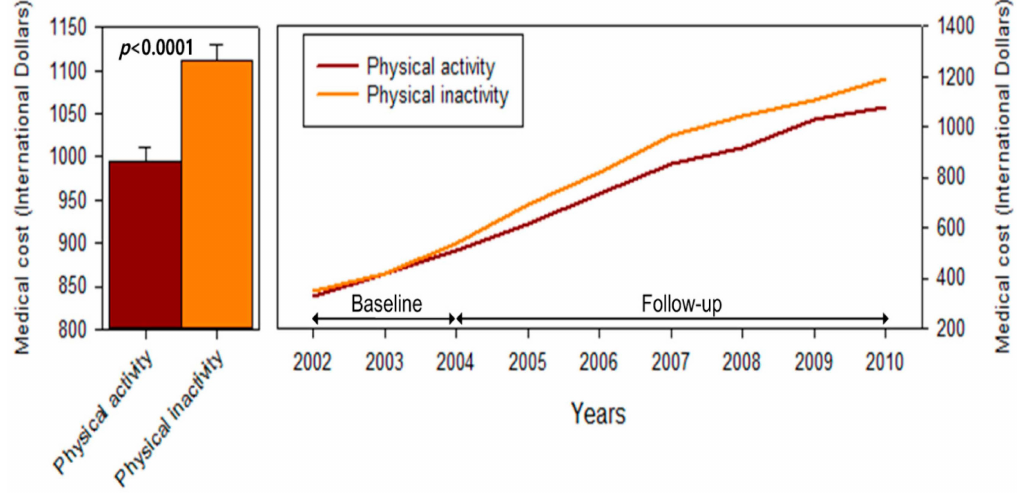
Figure 2. Medical expenditures for physically inactive and active people.